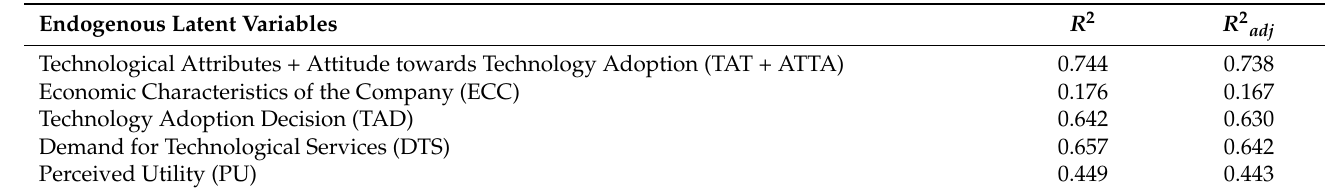
Table 9. Explained variance ( R 2 ).